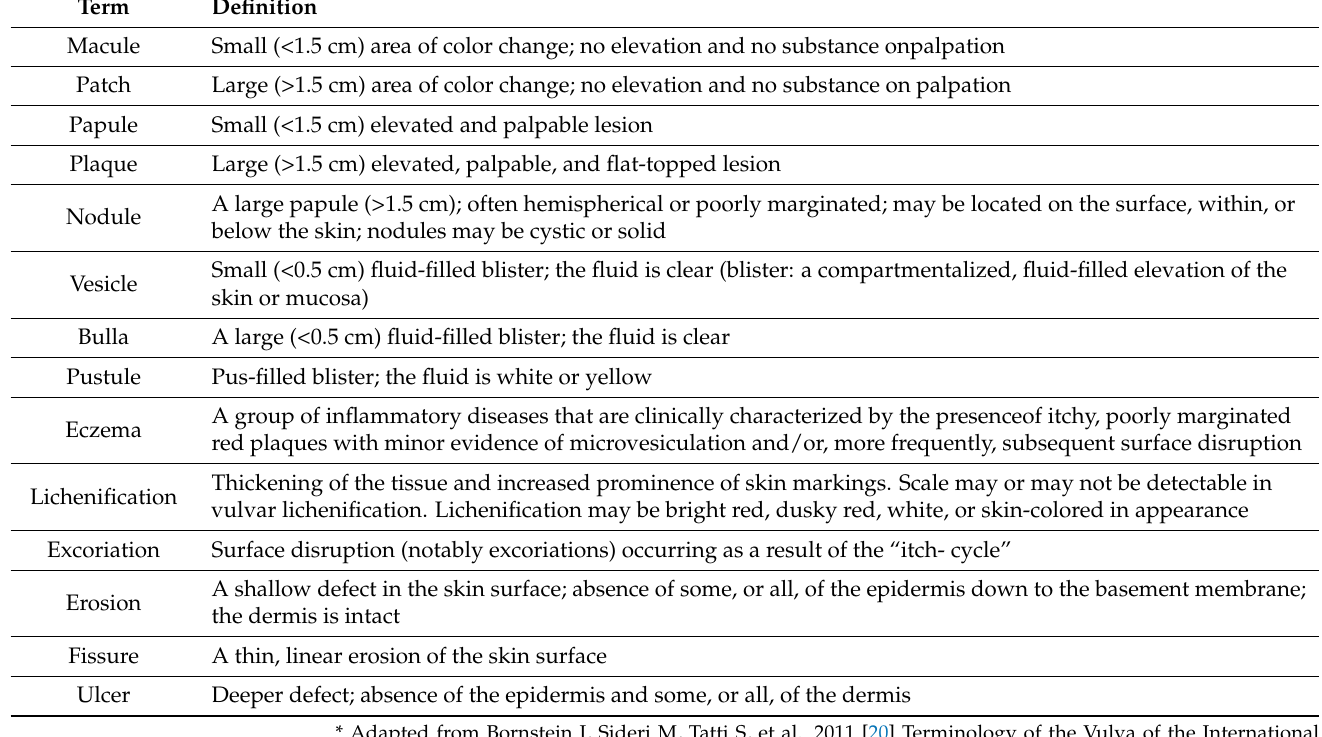
Table 2. Definitions of primary lesion types *.